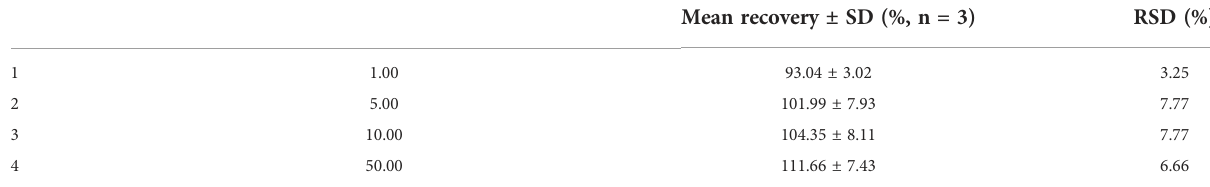
TABLE 3 Recoveries of samples spiked with OA by TRFIA.